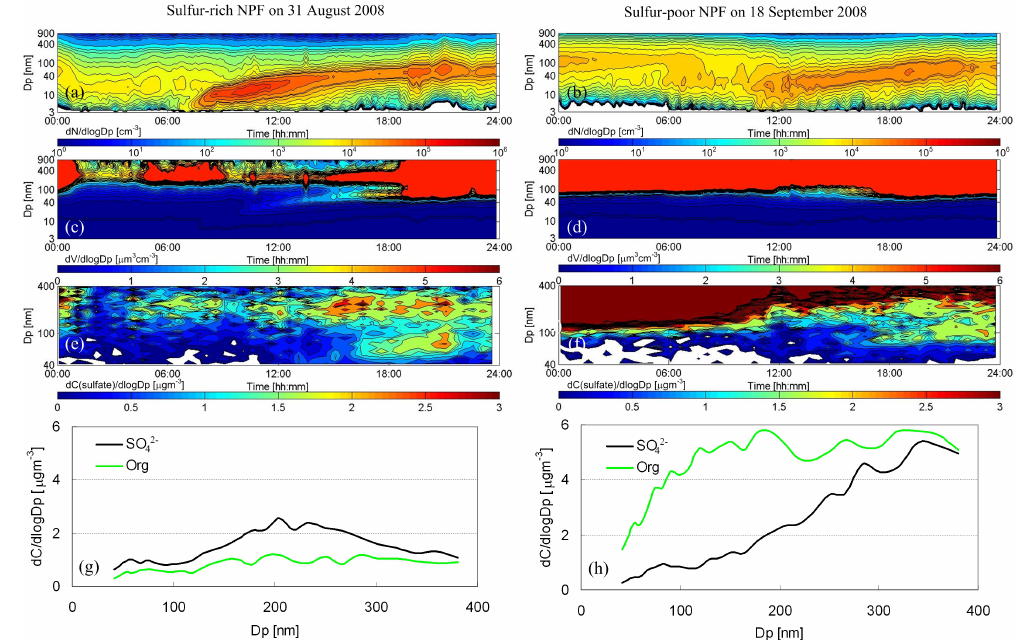
Fig. 4. Particle number size distributions (a, b) , particle volume size distributions (c, d) , sulfate mass size distributions (e, f) , and comparison of average mass size distributions between sulfate and organic compounds from 14:00 to 18:00LT (g, h) on sulfur-rich and sulfur-poor NPF event days,